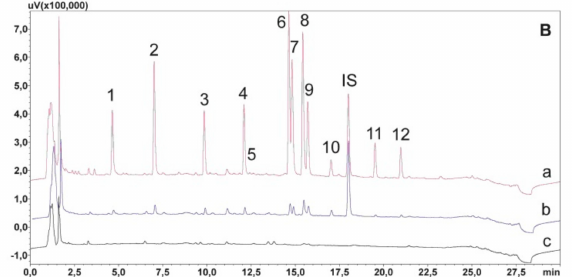
Figure 2. ( A ) Chromatogram of the standard solutions obtained by optimized UHPLC; ( B ) chromatogram of saliva sample extracts obtained after washing the sorbent with water and a mixture of water and methanol (1:1) and eluted with 5% ammonia solution in methanol; a—spiked with 750 ng / mL; b—spiked with 150 ng / mL; c—blank saliva sample extract.